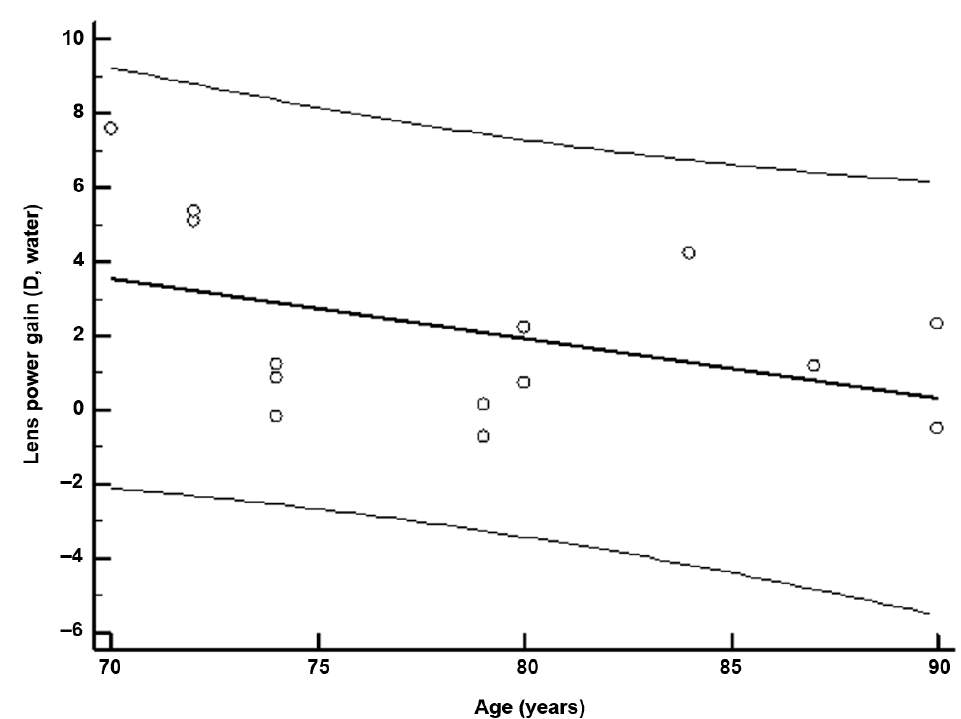
Figure 2. Effect of age on lens power improvement. Y [lens power, D (water)] = 14.96 − 0.163 (age, years) (r 2 = 0.187, p = 0.07).